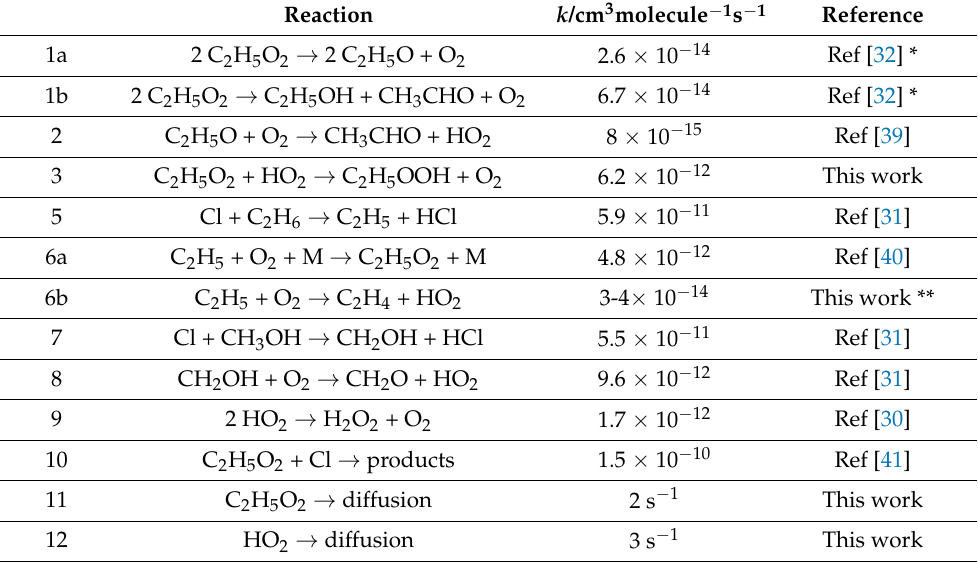
Table 3. Reaction mechanism used to fit all experiments in this